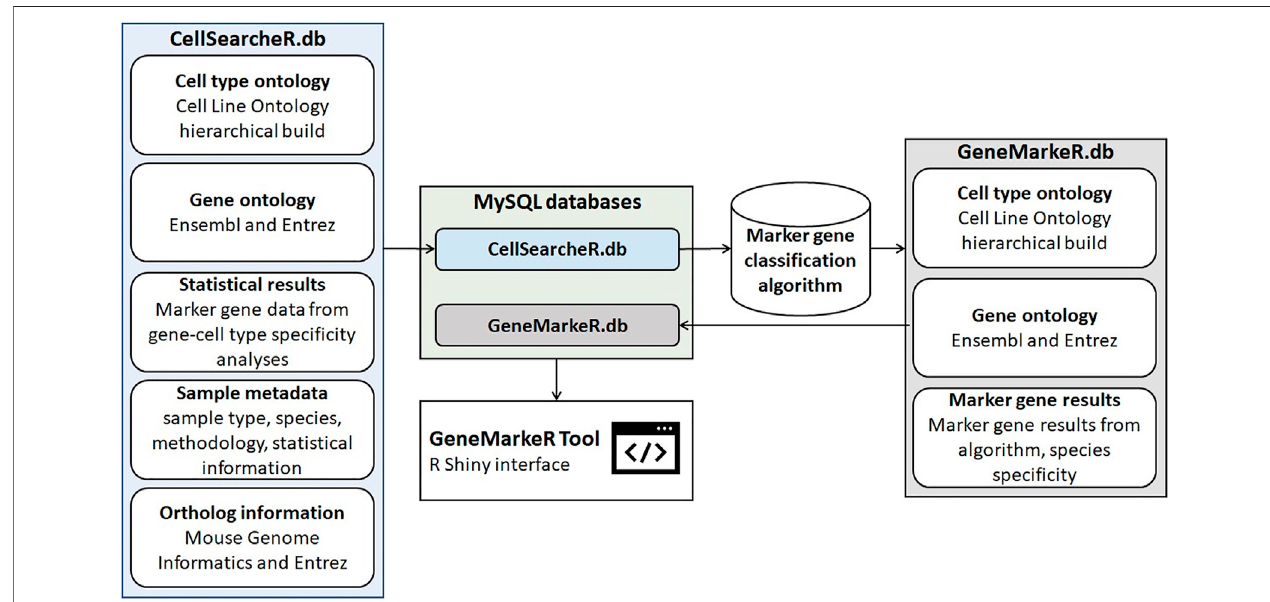
FIGURE 3 | Schema for generation of GeneMarkeR. The CellSearcheR database (CellSearcheR.db) integrates standardized cell type, gene and statistical data from publications performing marker gene identi fi cation analyses on non-treated, non-disease mouse and human samples. Data was manually extracted, cell types mapped to the Cell Line Ontology hierarchical ontology, genes mapped to Ensembl and Entrez identi fi ers and statistical data normalized to a marker gene score. CellSearcheR.db is processed by the marker gene classi fi cation algorithm detailed in Figure 2 . The GeneMarkeR database (GeneMarkeR.db) integrates the standardizedcelltype,geneandmarkergeneresultsfromthealgorithmoutput.CellSearcheR.dbandGeneMarkeR.dbareMySQLdatabasesthatareaccessedviaanR Shiny user interface called GeneMarkeR.